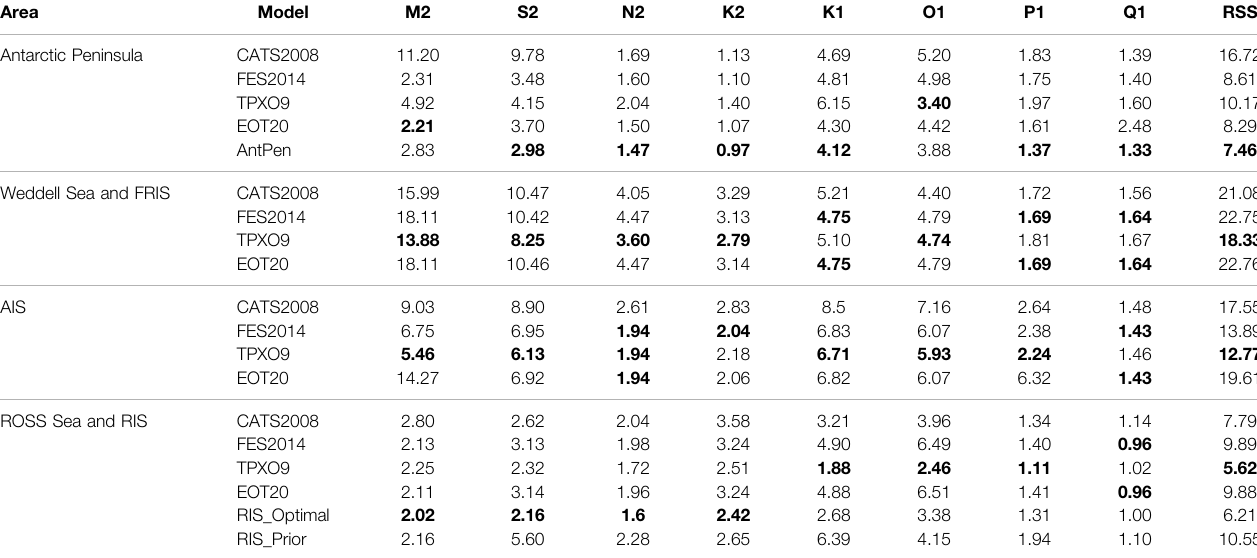
TABLE 2| Comparisonbetween fi vetidemodelsandtidalrecordsforeightmainconstituentsintheAntarcticPeninsula, WeddellSeaandFRIS, AIS,andRossSeaandRIS. Bold values denote the smallest RMS and RSS values. (Unit: cm). Area Model Antarctic